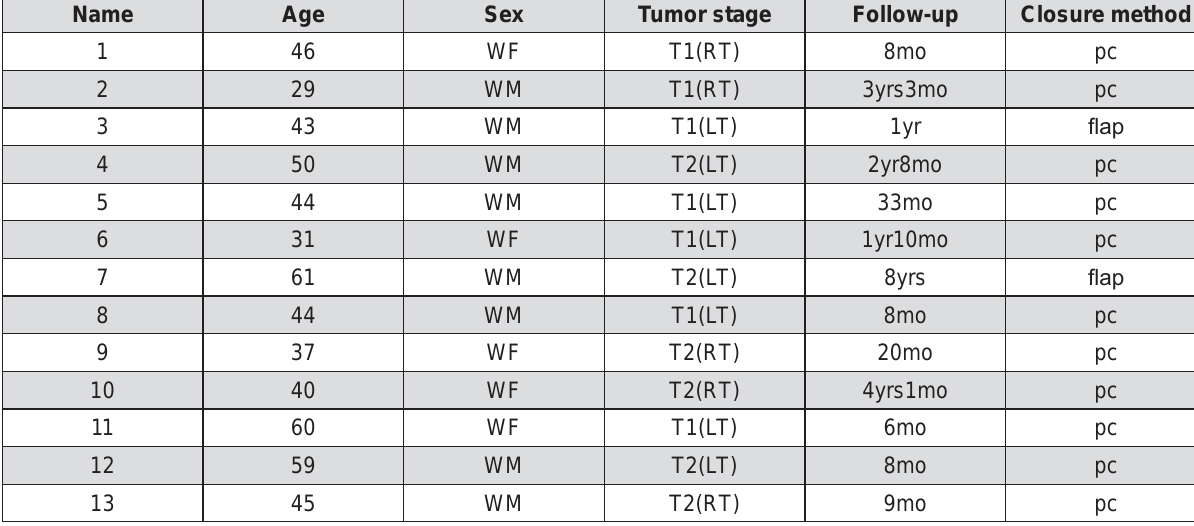
dataWF=white female ; WM=white male; PC=primary Figure 1- Summary of patient